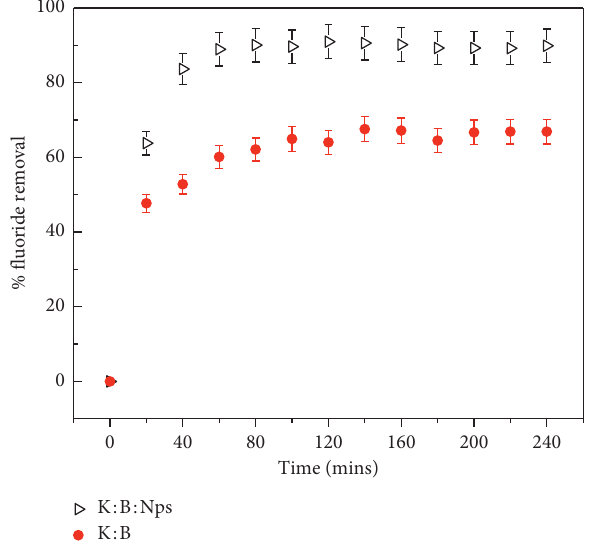
Figure 4: Effect of contact time on removal of fluoride.